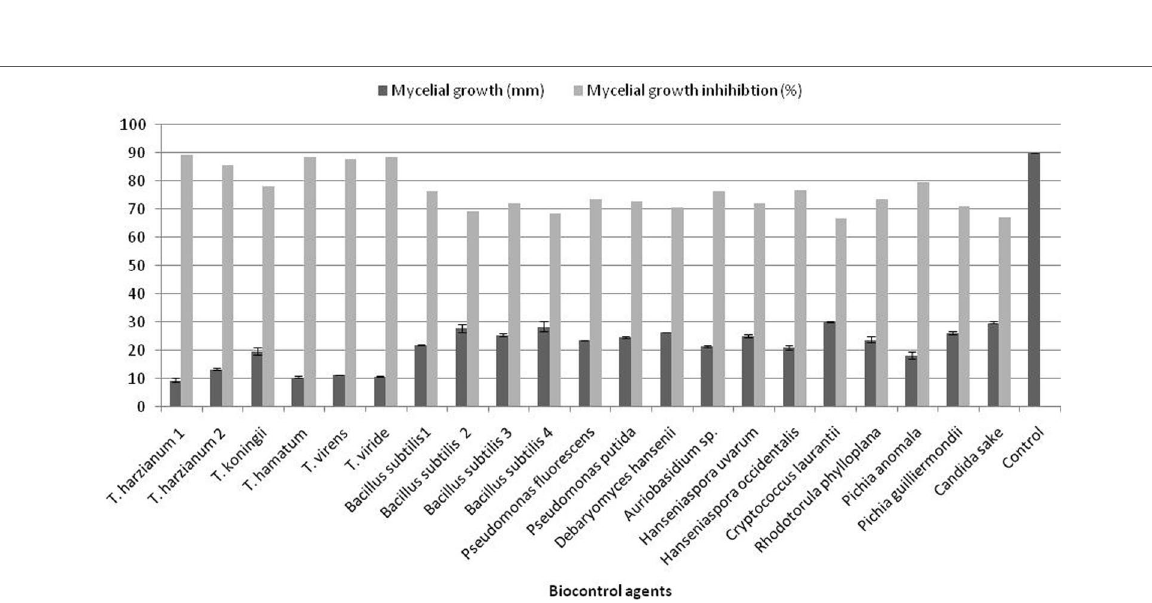
Fig. 2 Antagonistic activity of different bio-control agents on mycelial growth of Colletotrichum